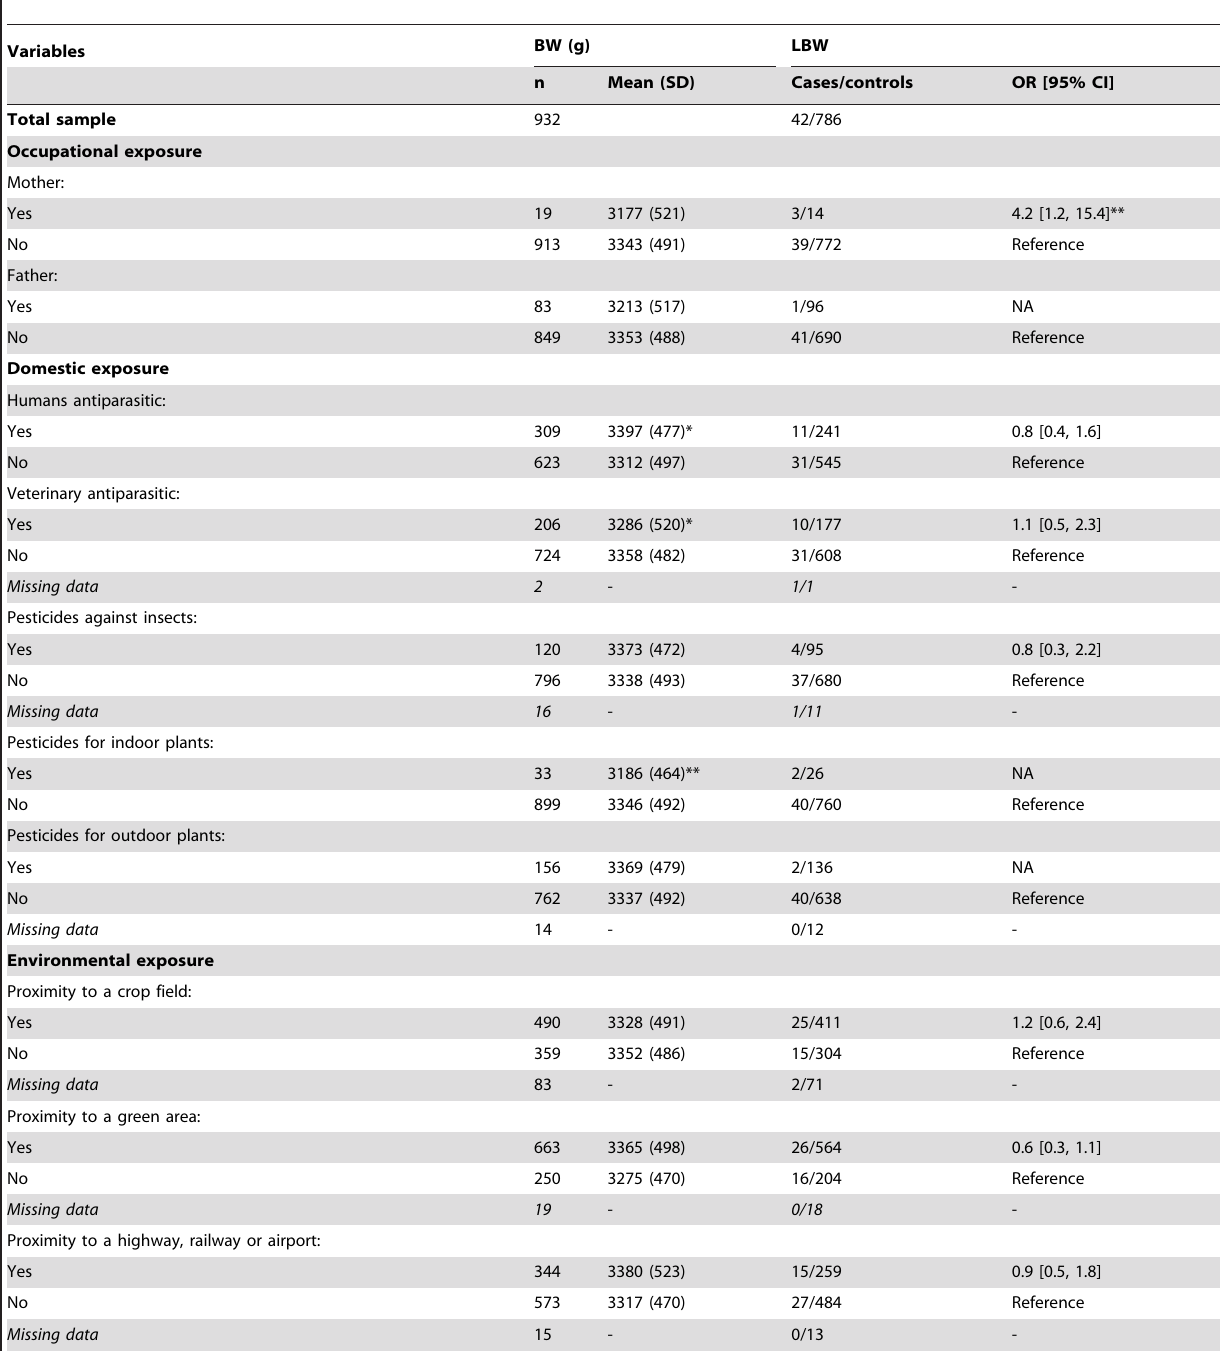
Table 7. Multivariate associations between (i) variables related to in utero exposure to pesticides, (ii) birth weight (BW, in g) and low birth weight